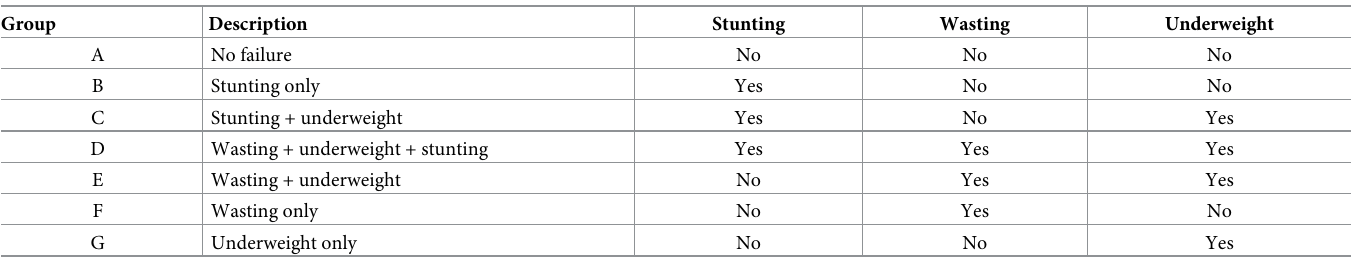
Table 1. CIAF classification of nutritional status in under-five